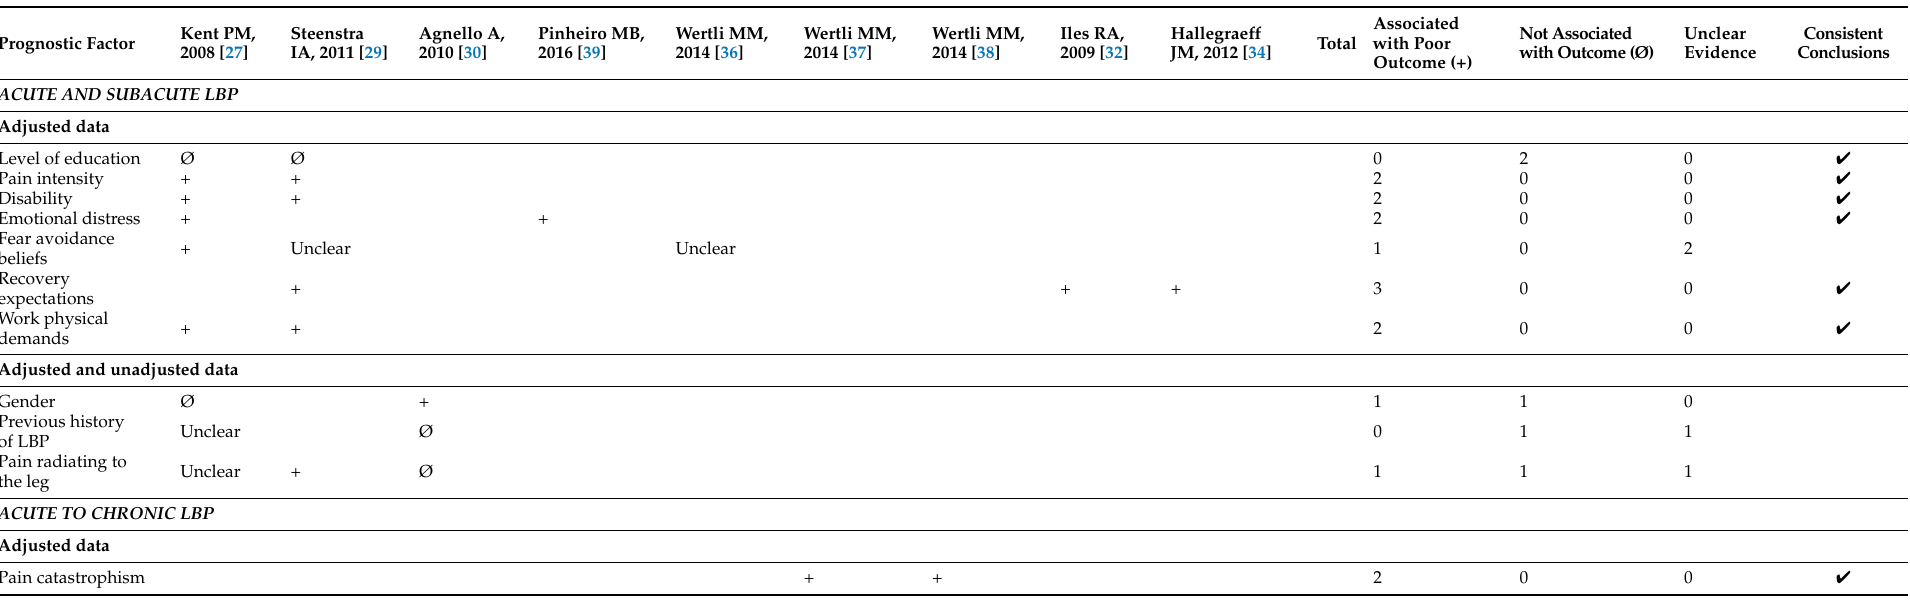
Table 3. Prognostic factors for LBP outcomes reported by two or more systematic reviews at long